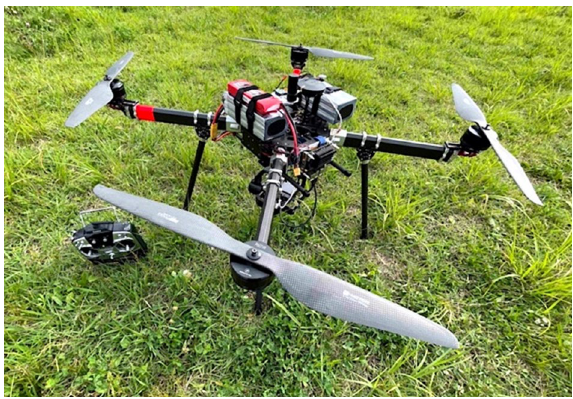
Figure 3. An image of the drone used.